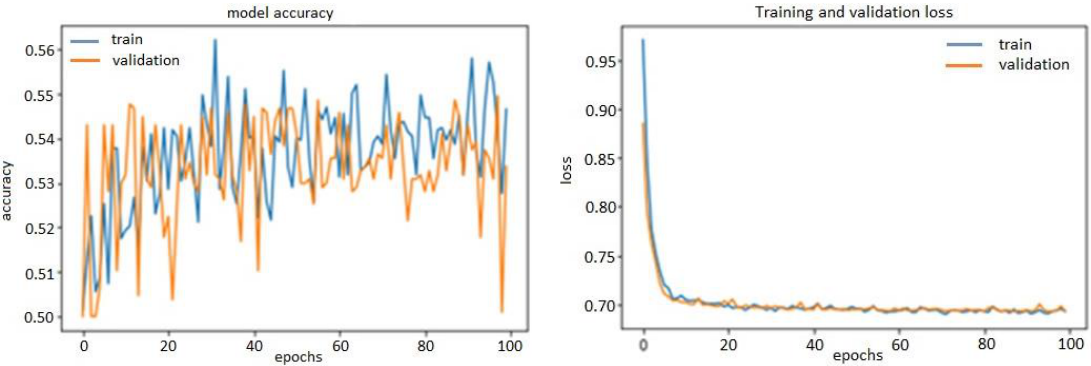
Figure 15. Accuracy and loss model of Wavelet_1D-CNN.